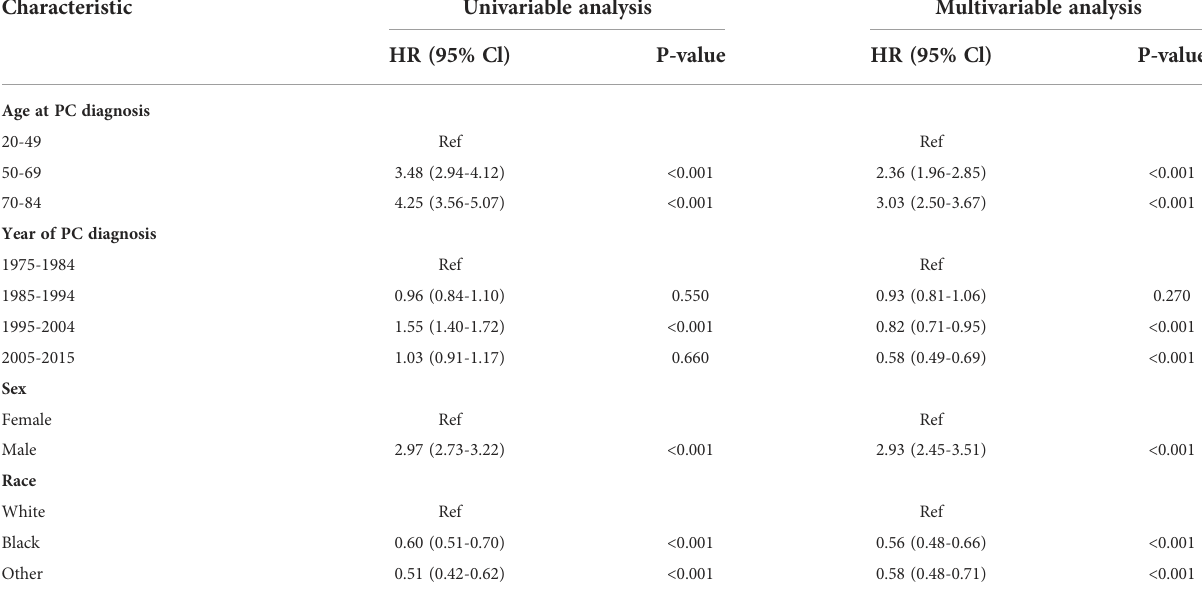
TABLE 2 Univariable and Multivariable Competing Risk Regression Analysis of Risk of Developing SBC in PC Patients. Characteristic Univariable analysis Multivariable analysis HR (95% Cl) P-value HR (95% Cl)